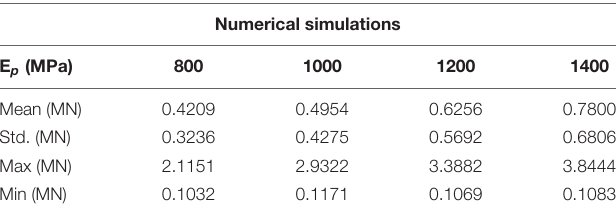
TABLE 4 | Comparison of the ice forces for the simulations with different plastic hardening modulus.